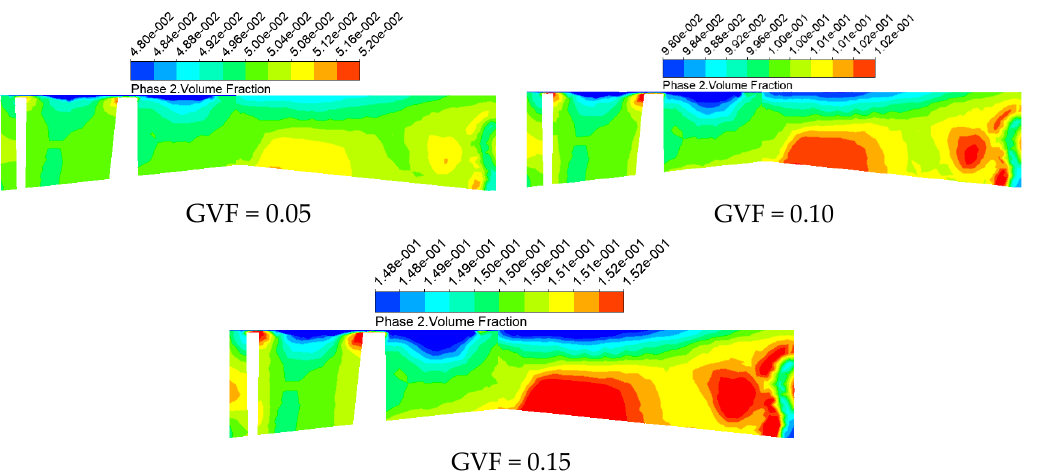
Figure 10. The axial gas-phase volume distribution in the pressurization unit with different GVFs.